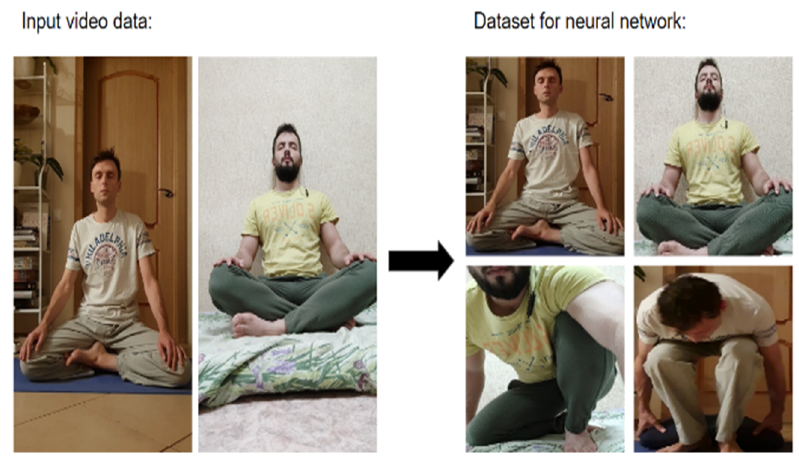
Figure 14. Converting video data to 180 × 180 px pictures.